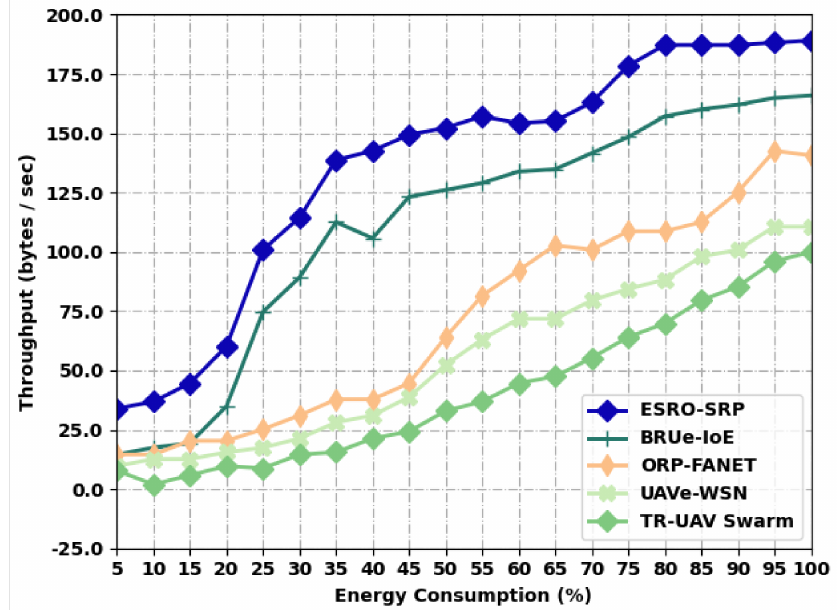
Figure 2. Throughput analysis of ESRO-SRP technique under distinct levels of